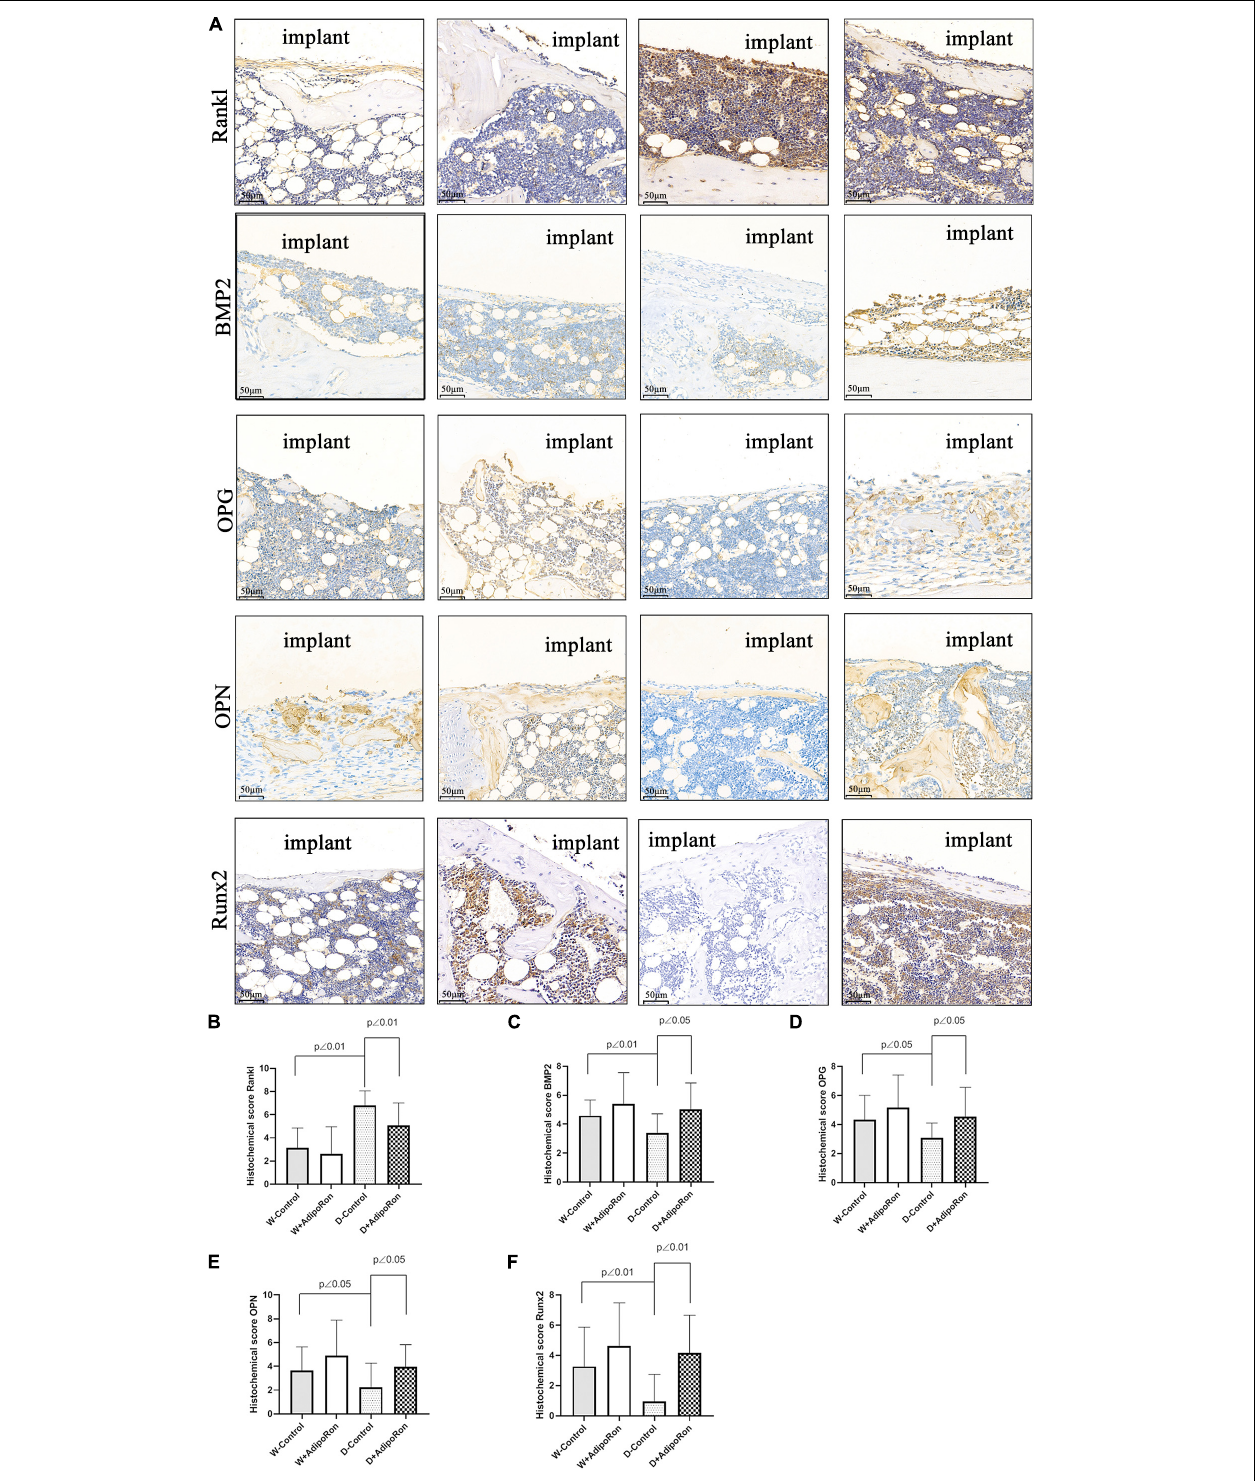
FIGURE 4 | Proteins of Rankl, BMP2, OPG, OPN, and Runx2 in femoral bone with dental implants in mice were quantized using immunohistochemical staining. Normal mice (Wild-control, W-control), normal mice treated with AdipoRon (Wild + AdipoRon, W + AdipoRon), diabetic mice (Diabetes-control, D-control), and diabetic mice treated with (Diabetes + AdipoRon, D + AdipoRon) were involved ( n = 7). (A) Femoral bone with dental implants in mice was immunohistochemically stained. One section in the region surrounding the explant of each sample was selected for analysis and five fields of vision were randomly selected in each section. Quantitation of Rankl (B) , BMP2 (C) , OPG (D) , OPN (E) , and Runx2 (F) are indicated using histochemical scores.